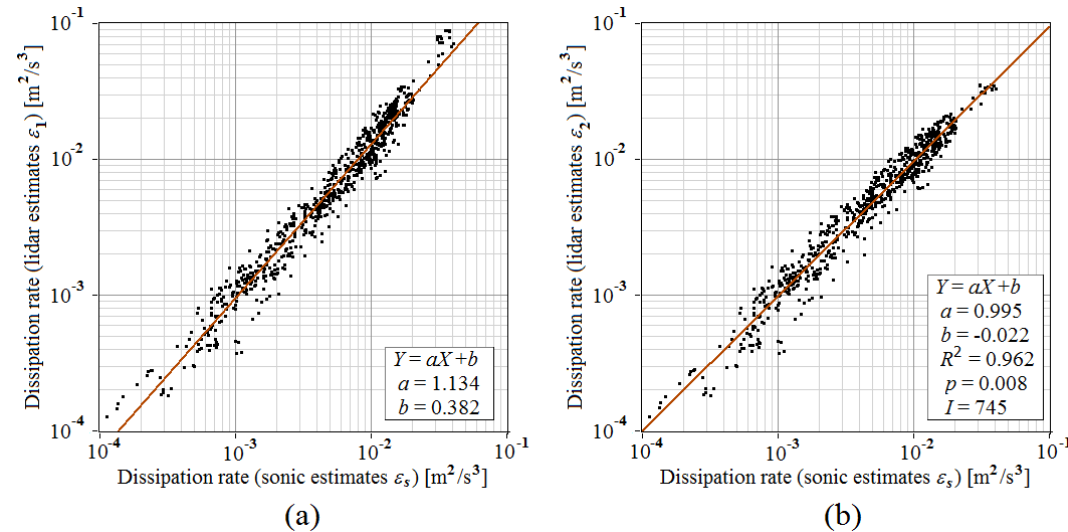
Figure 11. Comparison of estimates of the turbulence energy dissipation rate obtained from simultaneous measurements by the lidar (vertical axes) and the sonic anemometer (horizontal axes). Lidar estimates of the dissipation rate were obtained with Methods 1 ( a ) and 2 ( b ). The data are taken from Figure 10b. In ( a , b ), the brown line is the best fit given by equation Y i = aX i + b , X i = lg ( ε s )